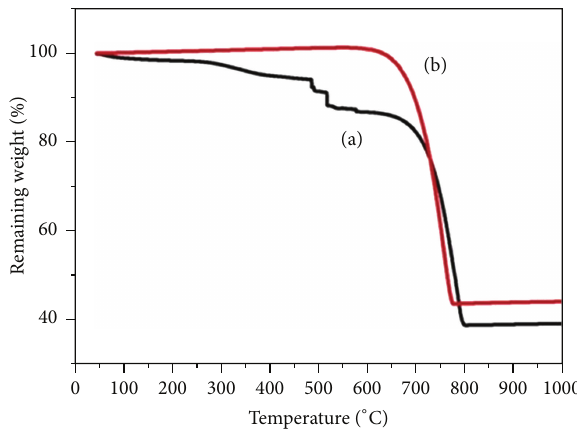
Figure 3: Thermogravimetric analysis of (a) eggshell and (b) commercial CaCO 3